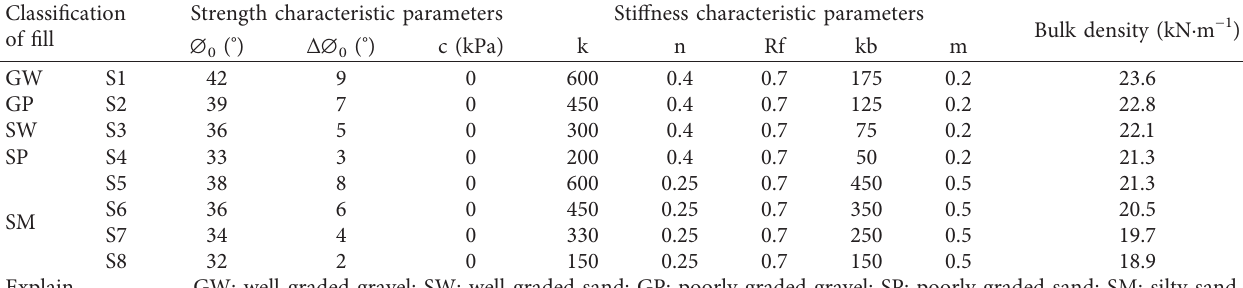
Table 4: Duncan–Chang constitutive model parameters of representative soil (Mohr–Coulomb). Classification Strength characteristic parameters of fill